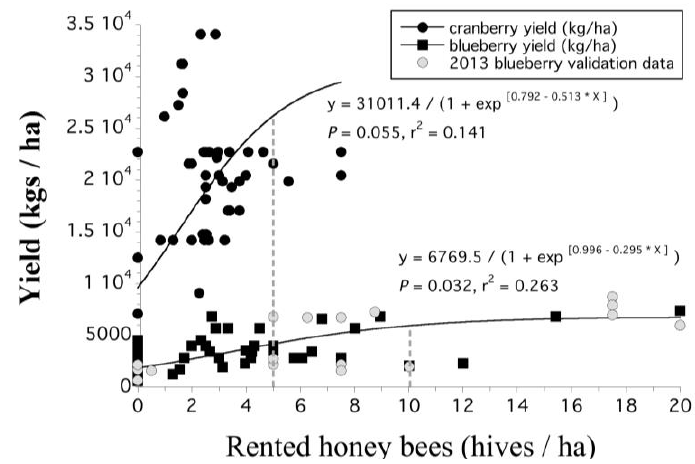
Figure 4. Production function of crop yield versus hive density for Maine, USA, wild blueberries and Massachusetts, USA, cranberries.